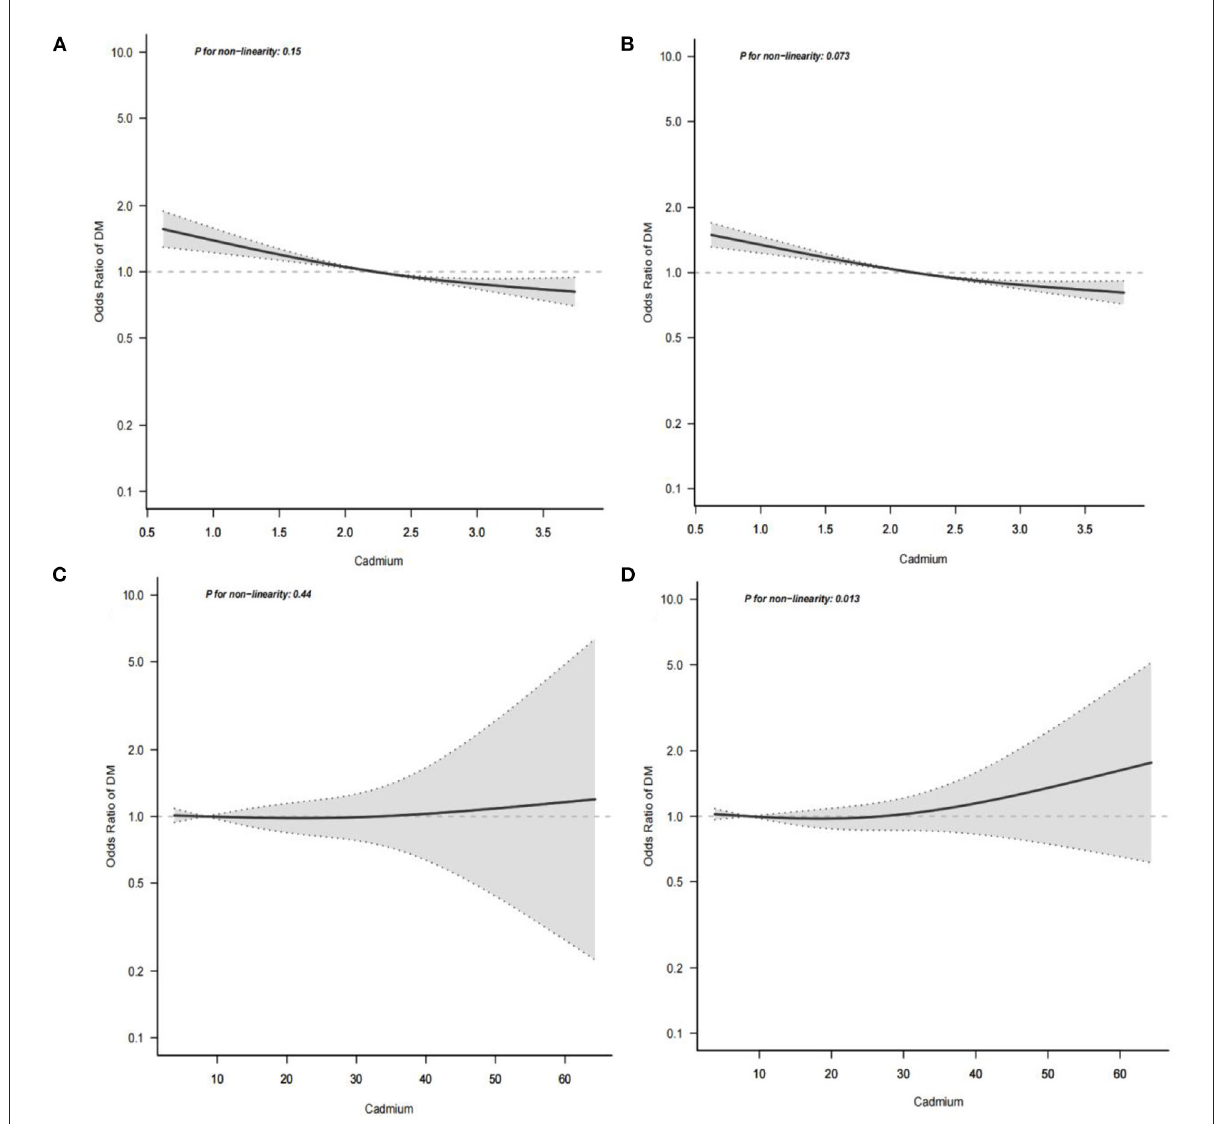
FIGURE3 Multivariate logistic regression analysis of the associations of serum cadmium levels with diabetes. The horizontal axis represents the serum cadmium level( mmol/L), and the vertical axis represents the relative probability of developing diabetes. (A) Shows the association between serum cadmium level and diabetes in low cadmium exposure group before missing covariates were imputed. (B) Shows the association between serum cadmium level and diabetes in low cadmium exposure group after missing covariates were imputed. (C) Shows the association between serum cadmium level and diabetes in high cadmium exposure group before missing covariates were imputed. (D) Shows the association between serum cadmium level and diabetes in high cadmium exposure group after missing covariates were